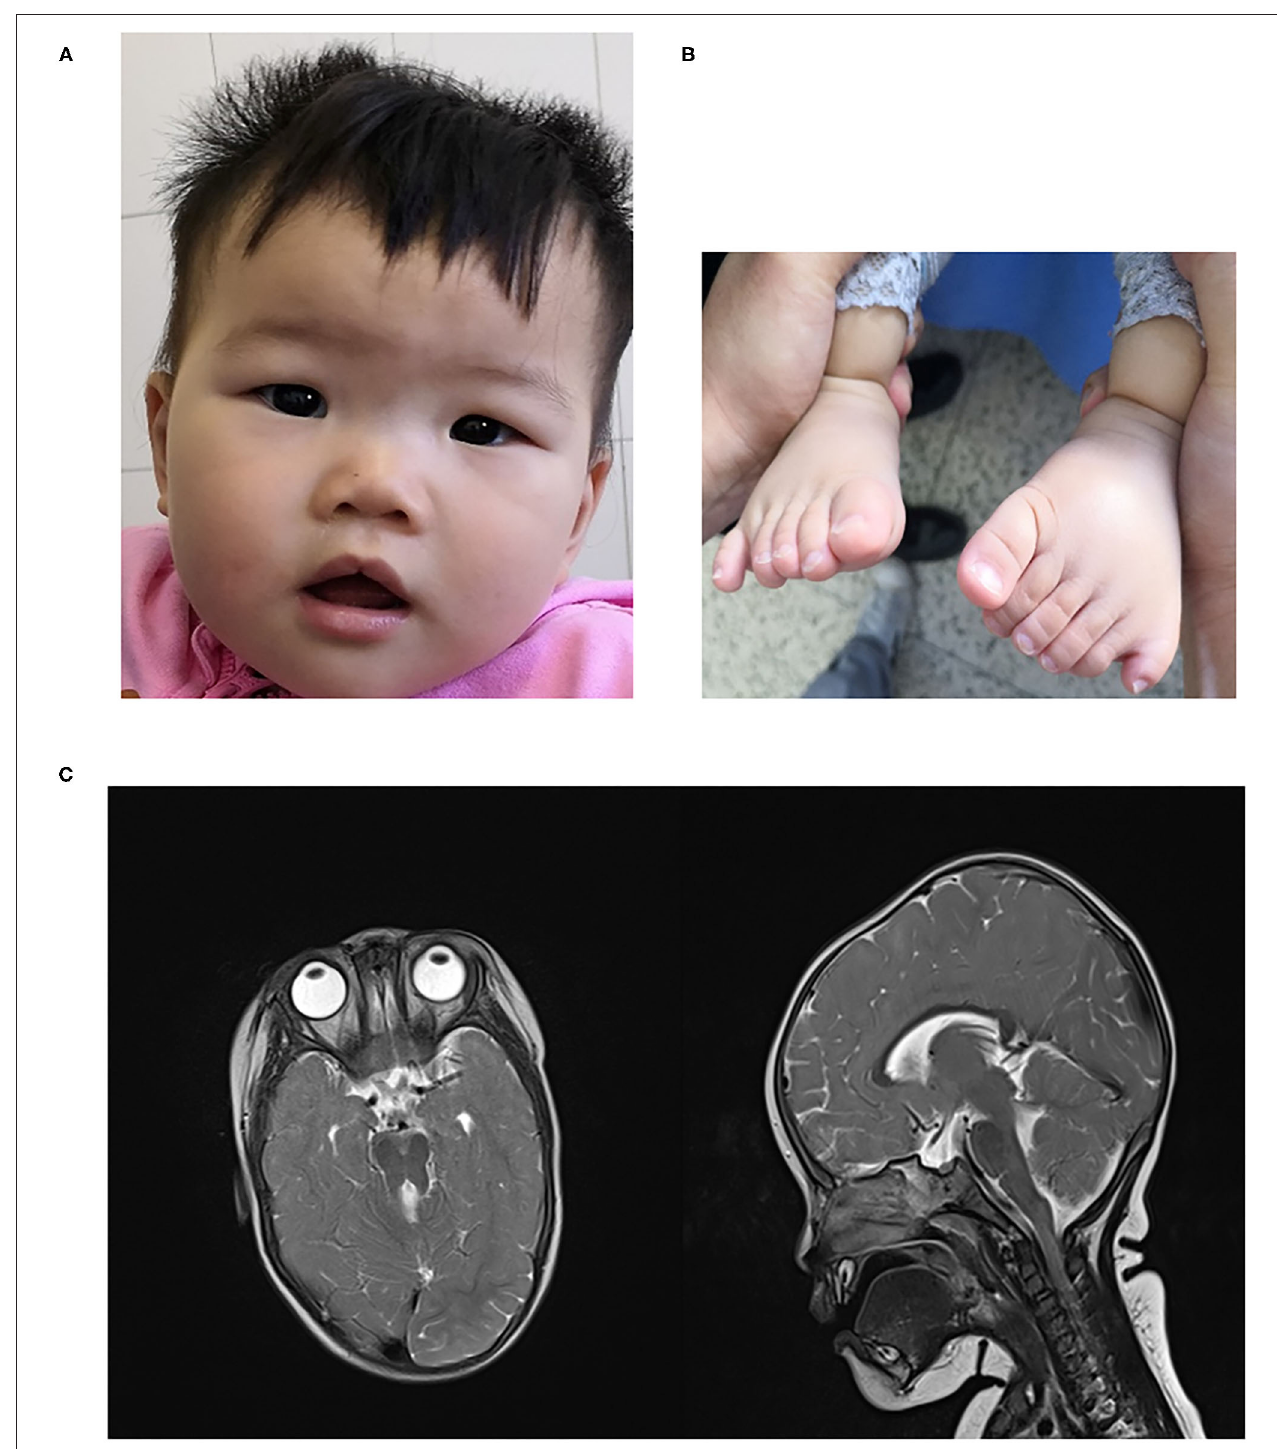
FIGURE 1 | (A) craniofacial dysmorphism (B) . polydactyly (C) MTS in brain MRI.